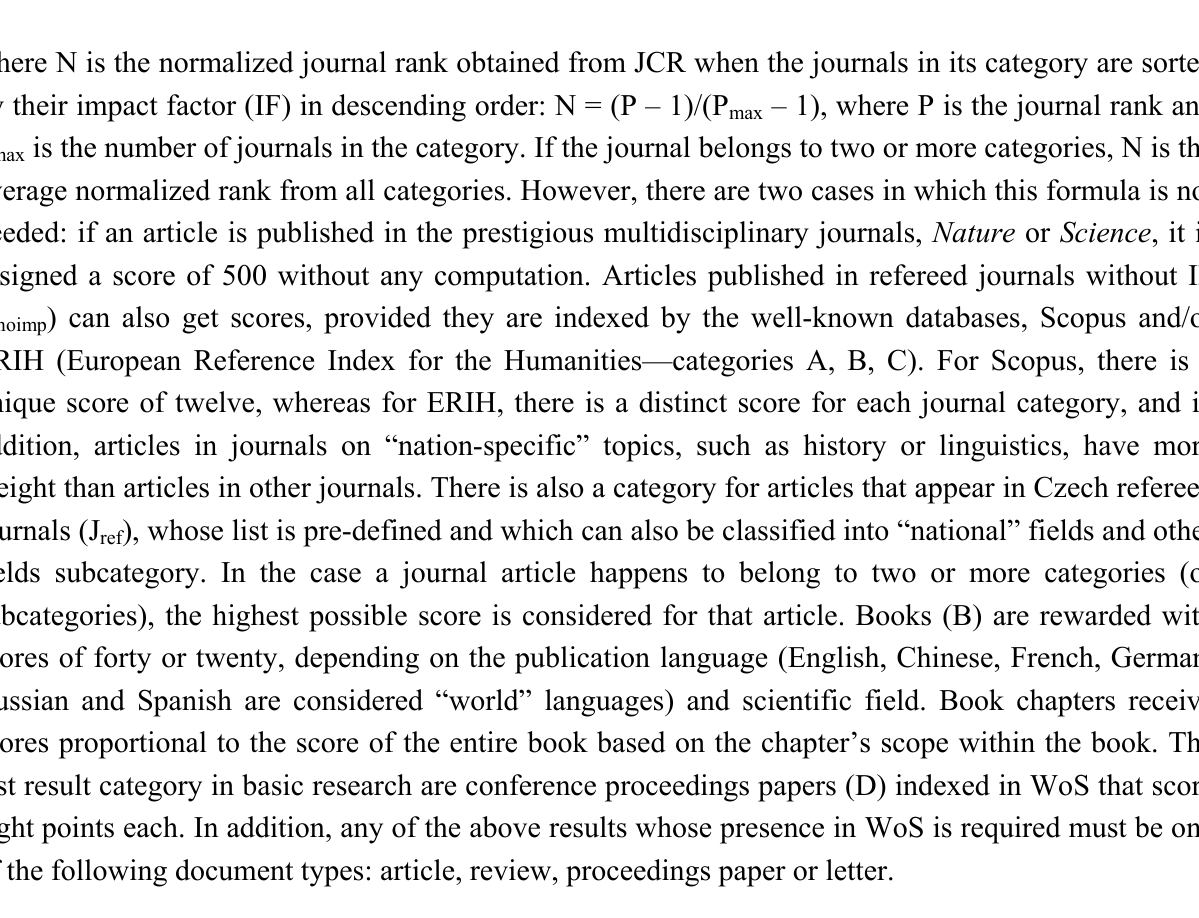
Table 2. Research result categories and their scores. ERIH, European Reference Index for the Humanities. EPO, European Patent